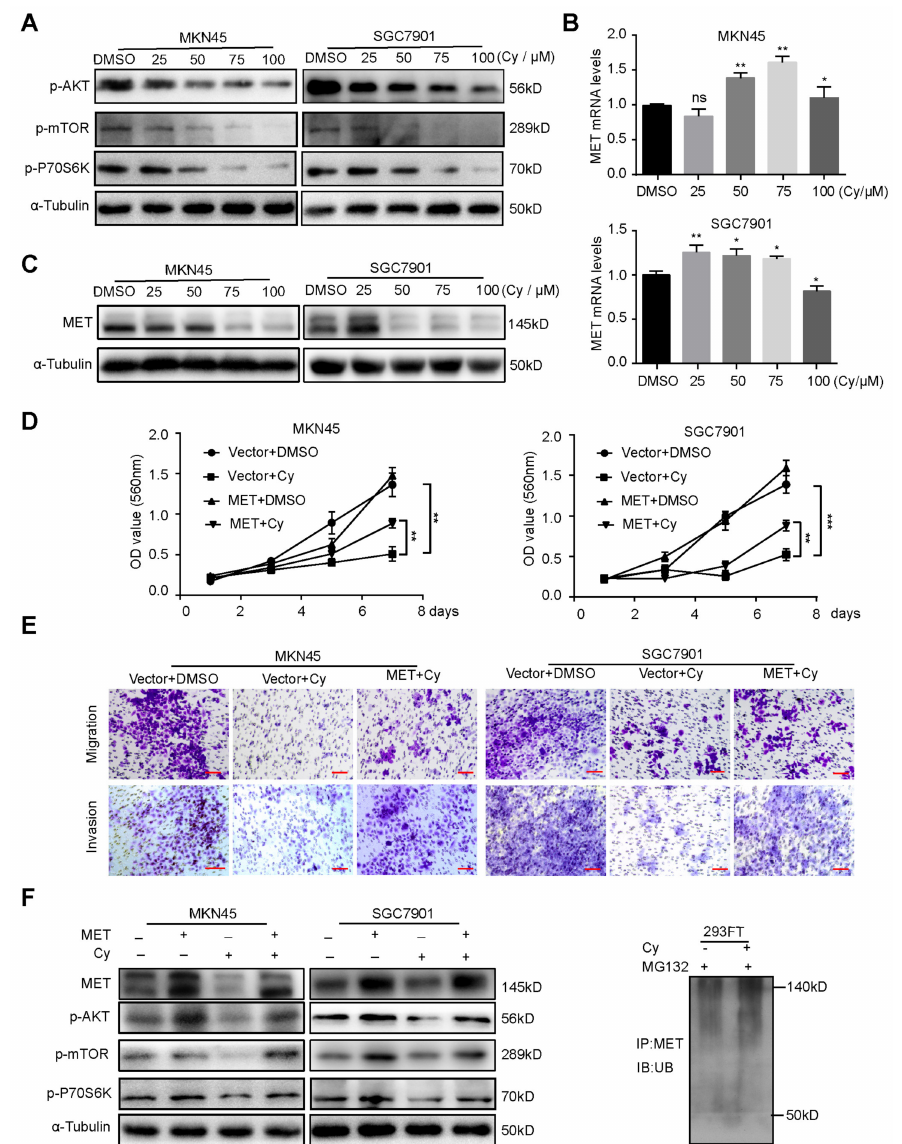
Figure 5. Cynaroside inhibits the activation of the p-mTOR, p-P70S6K and p-AKT pathway by enhancing MET ubiquitination degradation. ( A ) The expression levels of p-mTOR, p-P70S6K and P-AKT proteins in MKN45 and SGC7901 cells were measured by Western blot treated with different concentrations of Cy. α -Tubulin was used as a control. ( B ) After treating the cells with different concentrations of Cy, fluorescence quantitative PCR detects the mRNA level of MET. ( C ) The ex- pression of MET in gastric cancer cells exposed to 50 µ M Cy in 48 h. α -Tubulin was used as control. ( D ) Viability of MKN45 and SGC7901 overexpressing MET and vector under treatment with Cy (50 µ M), respectively. DMSO was added as a control. ( E ) The migration and invasion of MKN45 and SGC7901 overexpressing MET or empty vector under treatment with Cy (50 µ M), respectively. DMSO was added as a control. ( F ) The expression levels of p-mTOR, p-P70S6K and p-AKT proteins in MKN45 and SGC7901 cells which overexpressed MET and vector were measured by Western blot treated with different concentrations of Cy. α -Tubulin was used as control. (G) After 293FT cells were treated with 50 µ M Cy, IP analysis was used to detect the ubiquitination level of MET protein. * p < 0.05, ** p < 0.01, *** p < 0.001, p -values < 0.05 were considered as statistically